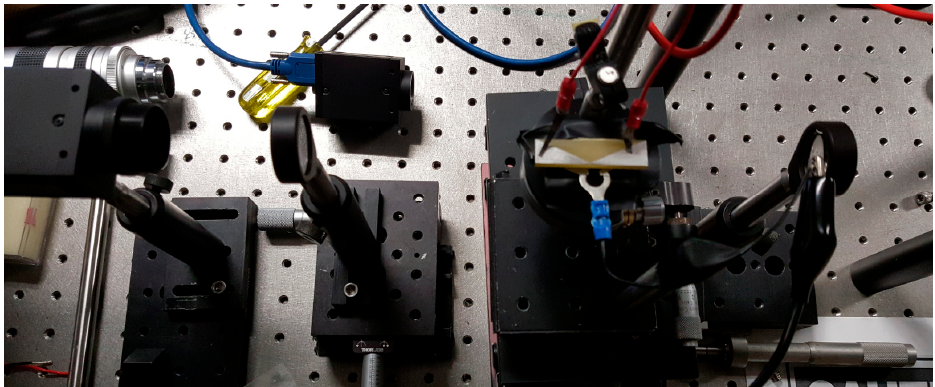
Figure 19. Light deflection test with the 7.5 mm × 7.5 mm × 40 mm polycrystalline PMN-PT with voltage electrodes.